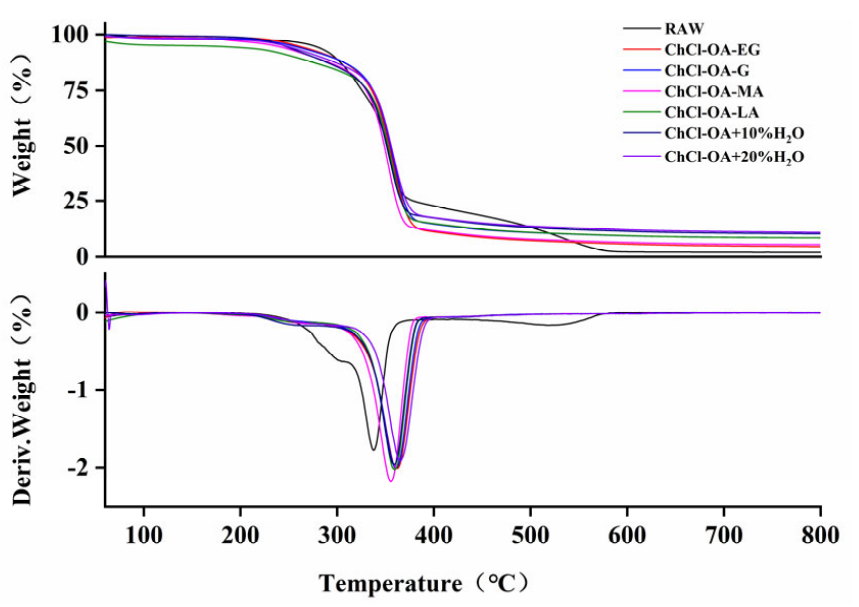
Figure 7. Thermogravimetric (TG)/Differential Thermogravimetric (DTG) curves of bagasse treated with different DESs.